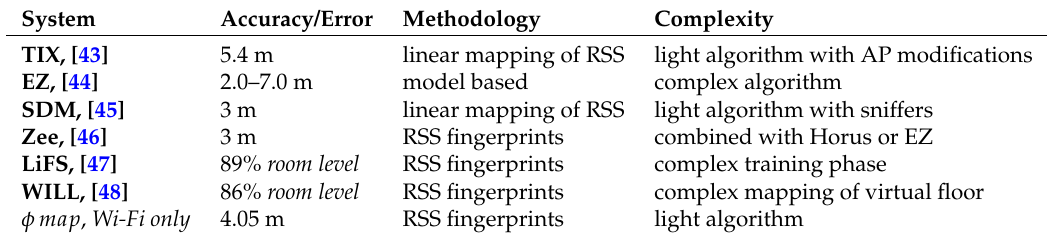
Table 3. Positioning error of typical indoor Wi-Fi positioning